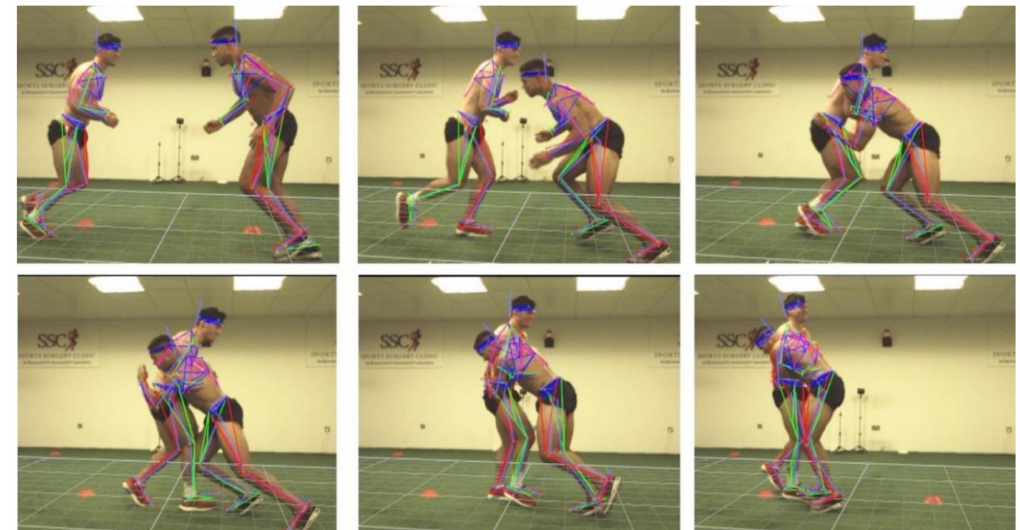
Figure 1. An image sequence of a tackle with the plug-in-gait model overlay.